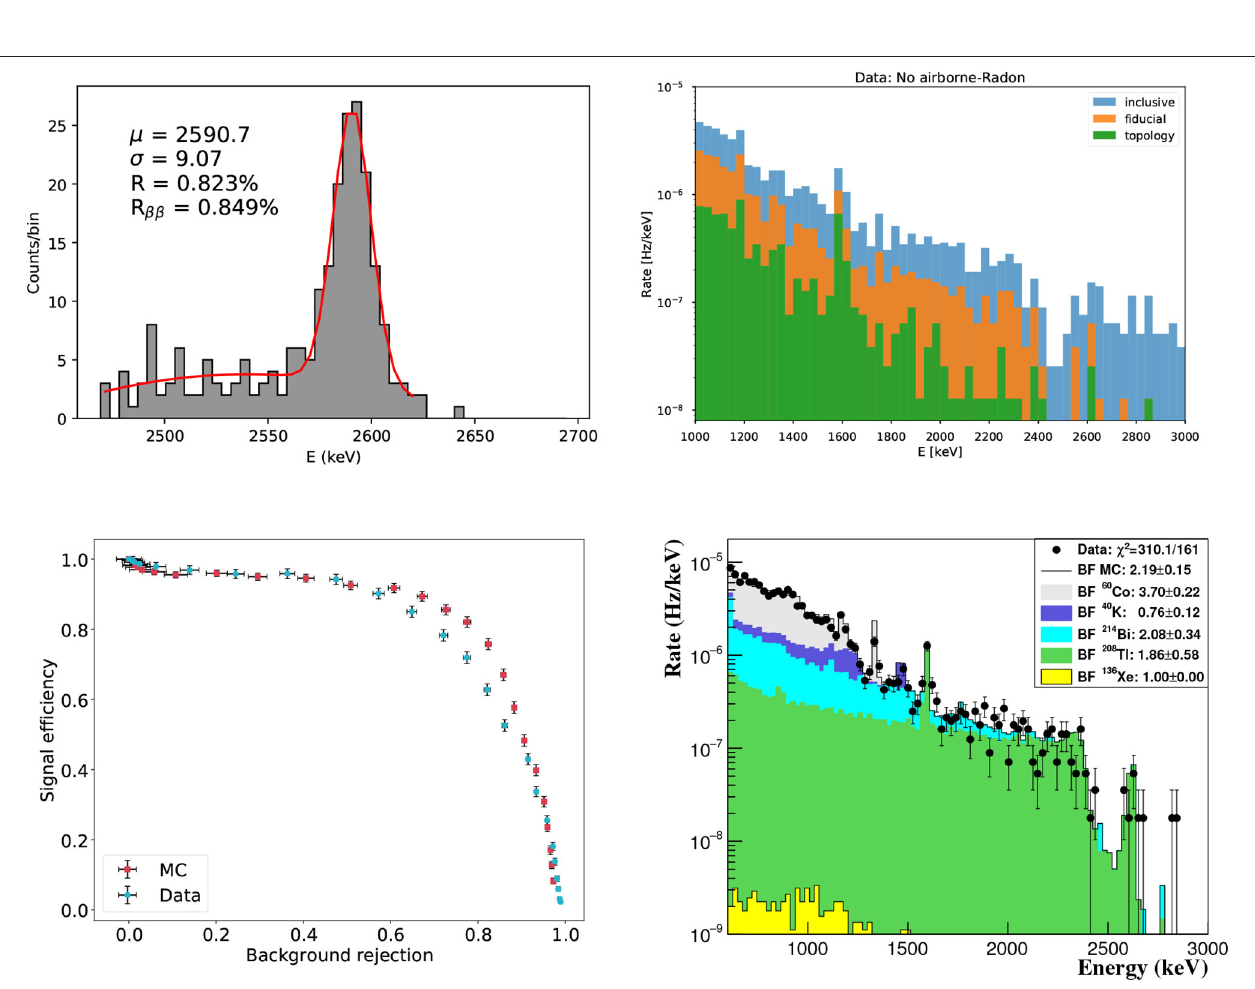
FIGURE 9 | A selection of the preliminary results obtained by NEXT-White. See text for details.